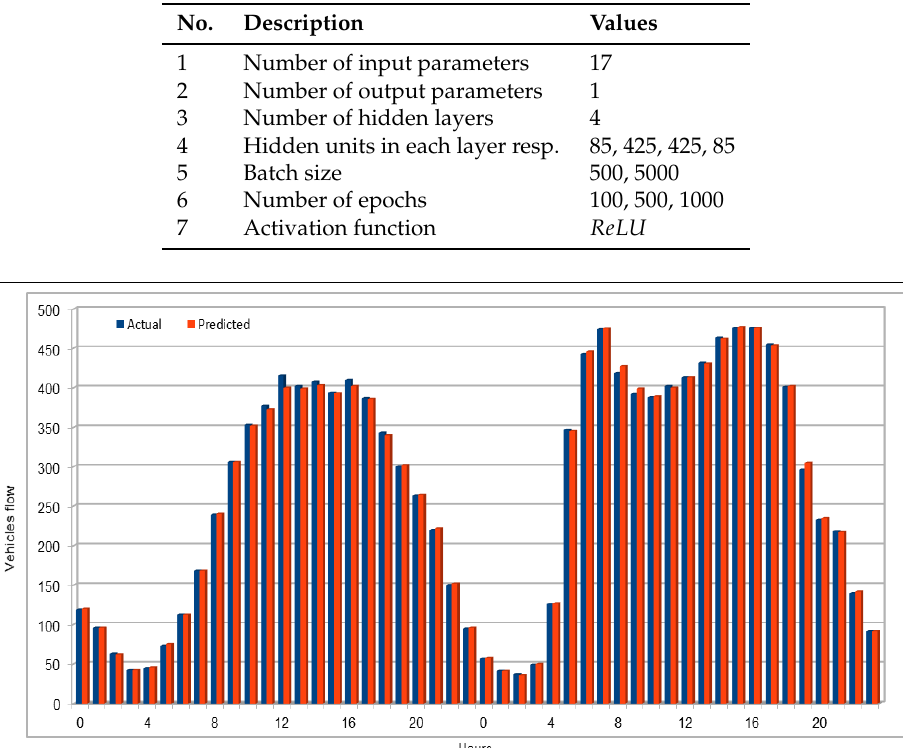
Figure 4. Traffic flow: Actual and predicted values for a single VDS.